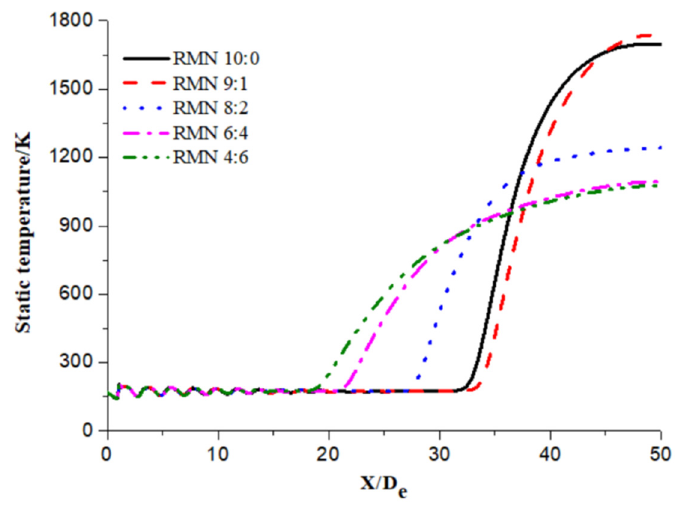
Figure 9. Static temperature distribution for various jets.